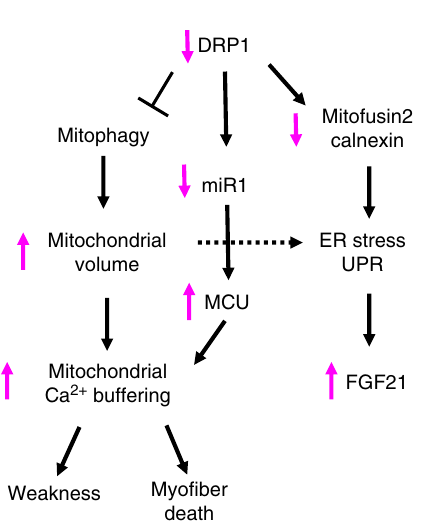
Fig. 8 Scheme of the mechanisms induced by acute DRP1 fi ssion de fi ciency. This fi nding opens the fi eld to a novel concept in which the shape and spatial organization of mitochondrial network, more than mitochondrial respiration, are sensed by the cell and activate a peculiar biological response. Therefore, the shape of the mitochondria is critical for mitochondrial function, but triggers different signaling pathways and biological processes that are peculiar of fusion or fi ssion impairment.